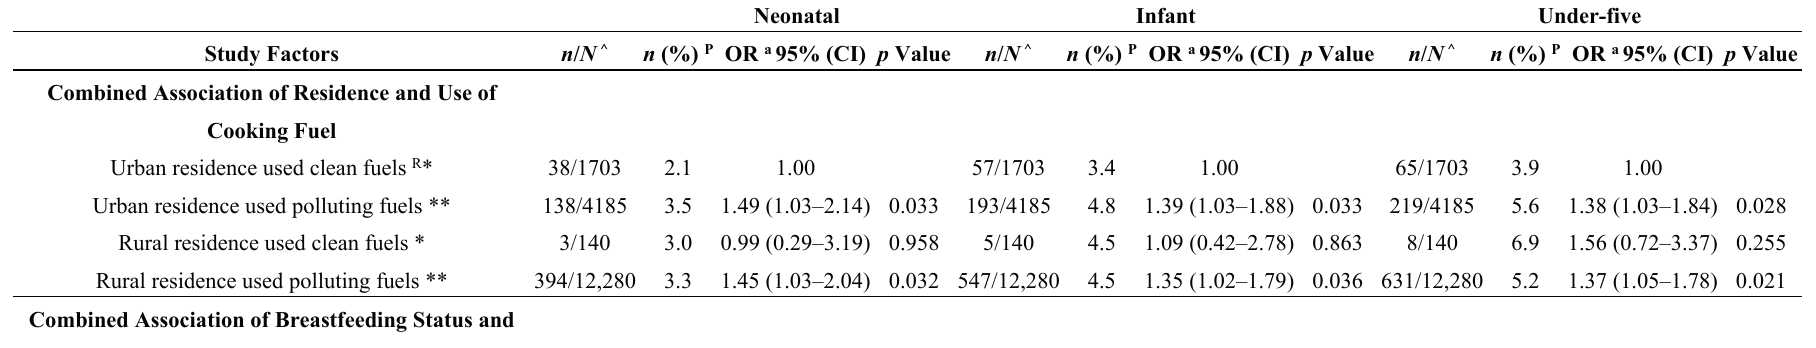
Table 2. Risk of mortality by geographical region, breastfeeding status and kitchen location. Neonatal Infant